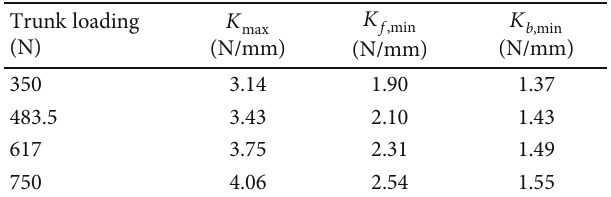
Table 3: Numerical bounds on the trunk sti ff ness in forward and backward